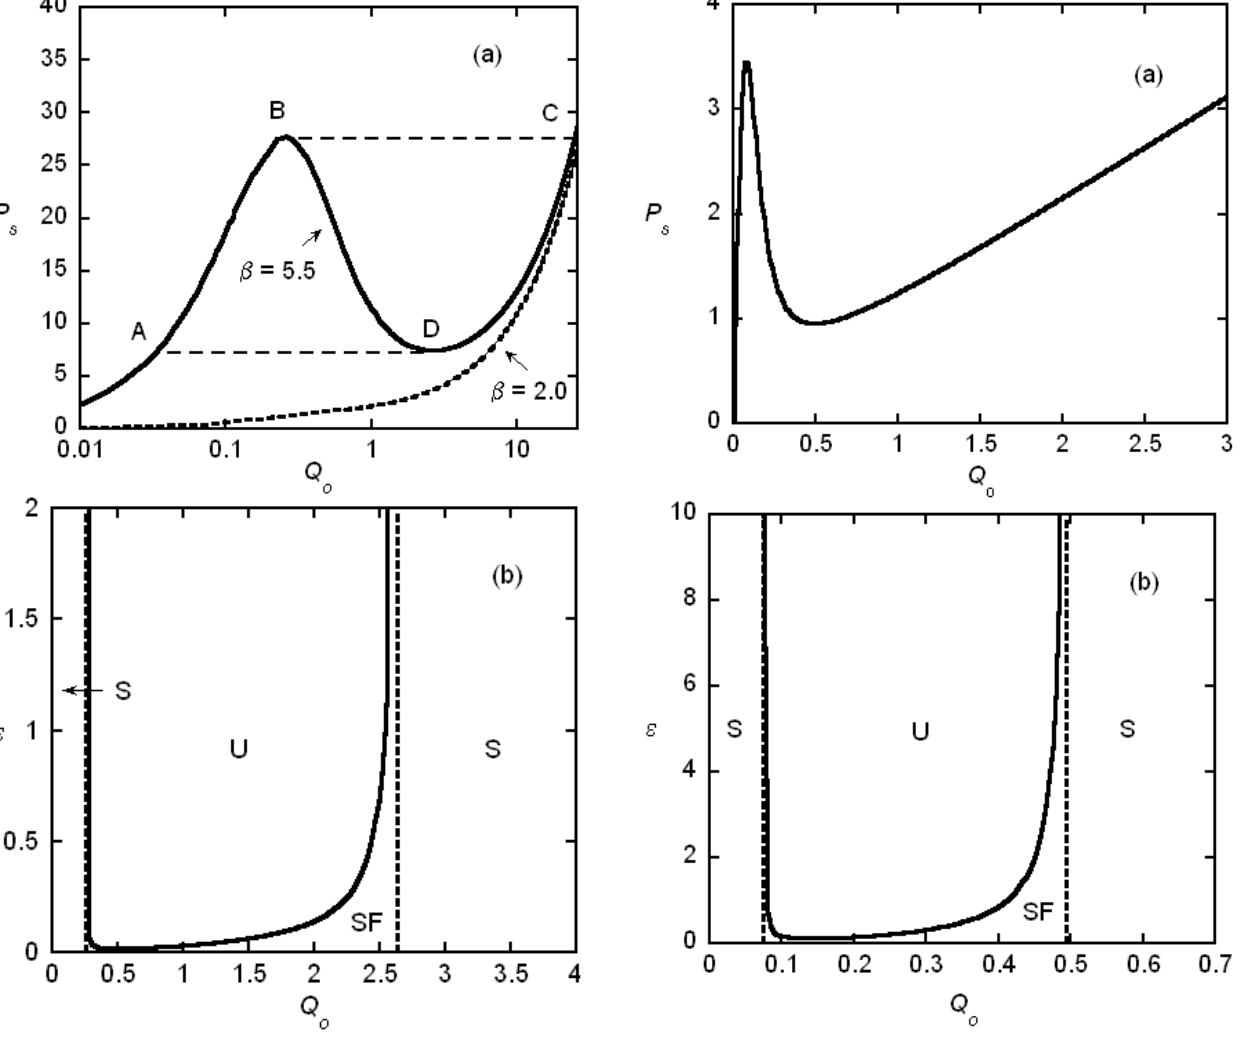
Fig. 2. (a) Steady state overpressure P s as a function of the flow rate Q o at the base of the conduit for the SBG model with β =5.5. (b) Steady state stability phase diagram in parameter space ( Q o , ε) for β =5.5 for the SBG bubble growth model. S=stable node; SF=stable focus; U=unstable focus. The Hopf bifurcation line (continuous curve) resides within the region where the steady state P s (Q o ) exhibits two extrema (dashed vertical